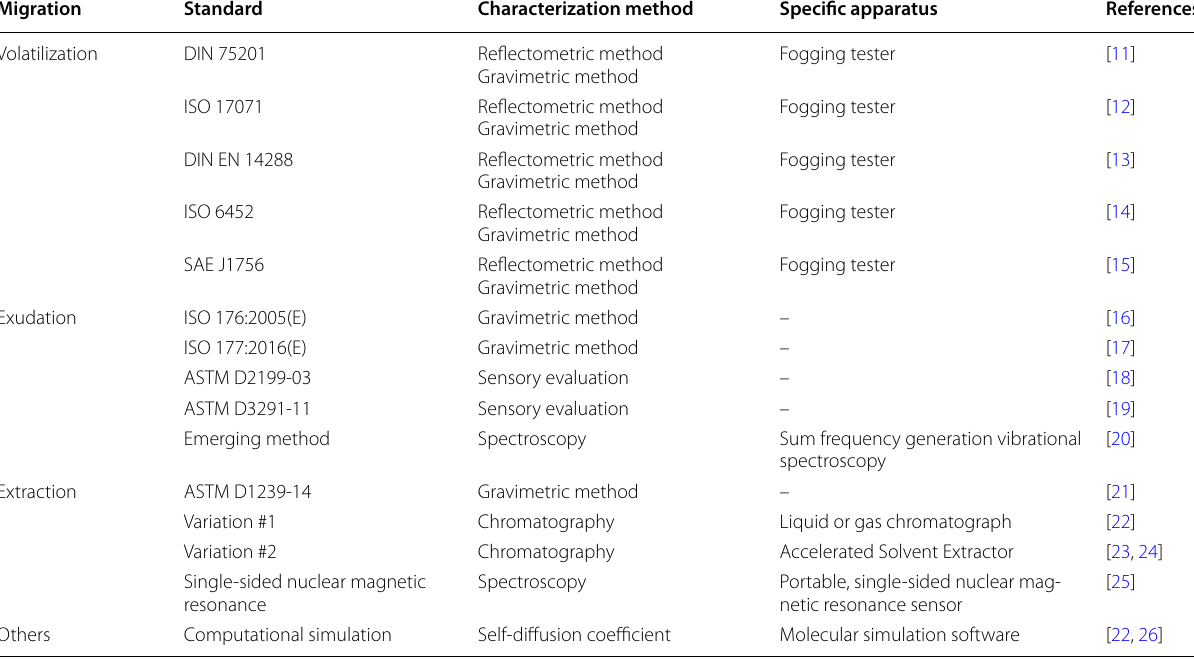
Table 1 Methods currently available for determination of plasticizer migration from PVC synthetic materials